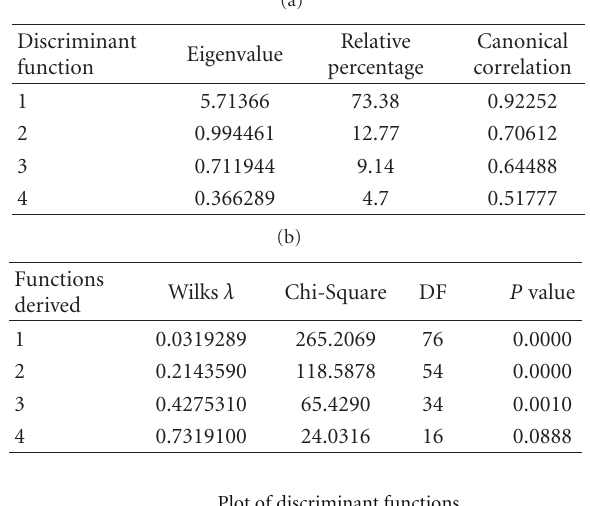
Table 2: Limit of quantitations (LOQs), limit of detections (LODs), percentage recovery of spike solutions analysed by ICP-MS. Spike 1 (rec.)